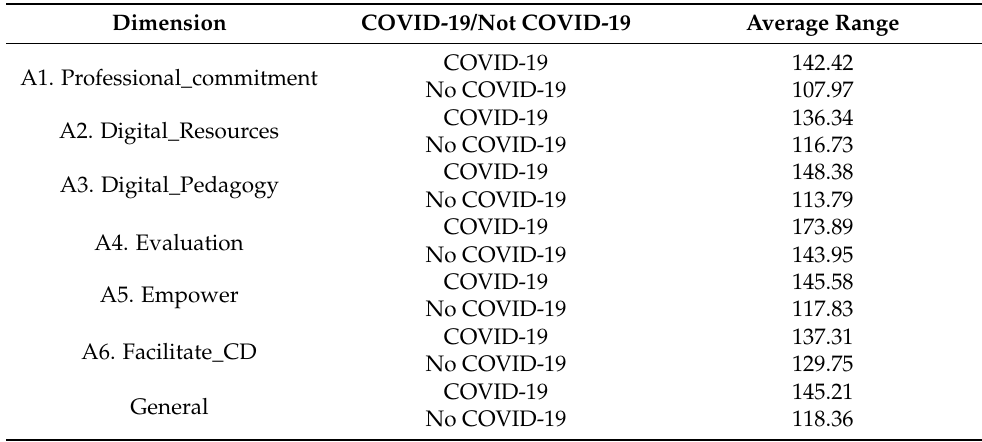
Table 7. Average ranges by dimensions in the posttest.